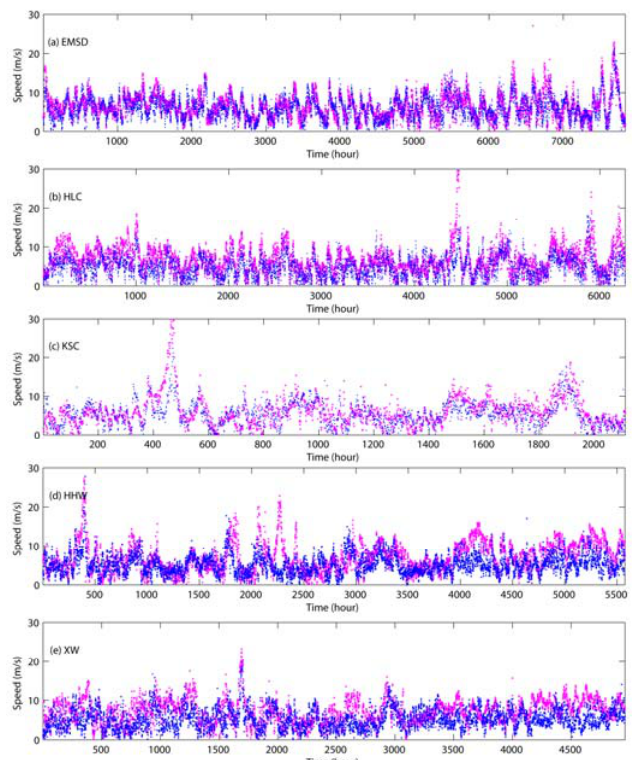
Figure 5. Comparison of hourly model results (red) and observational data (blue) at (a) Pottinger station maintained by EMSD, (b) HLC station maintained by CLP, (c) KSC station maintained by CLP, (d) Hung Hai Wan (HHW) and (e) Xu Wen